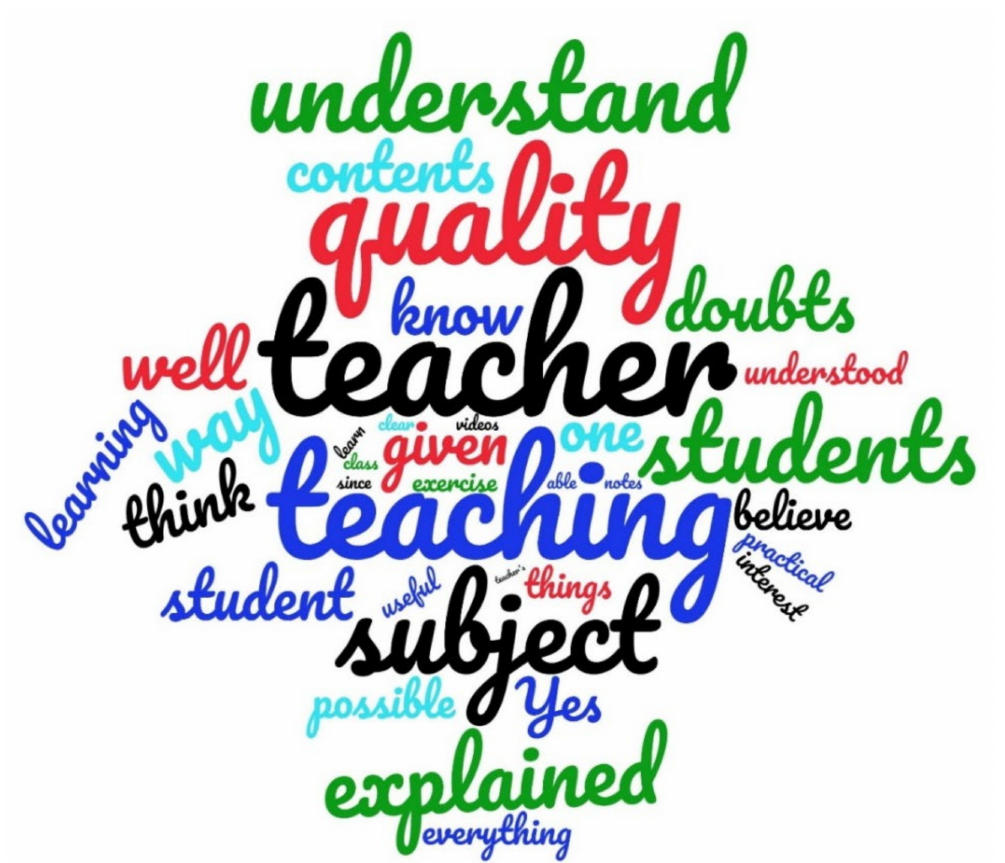
Figure 7. Word Cloud of question 5 for Week